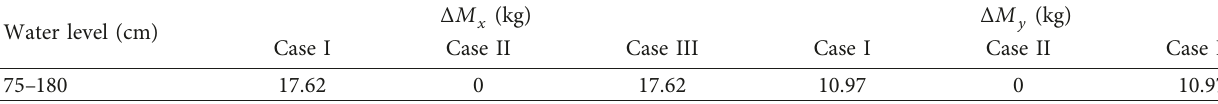
Table 6: HAM of the pile cap along the x -axis and y -axis in the three cases.